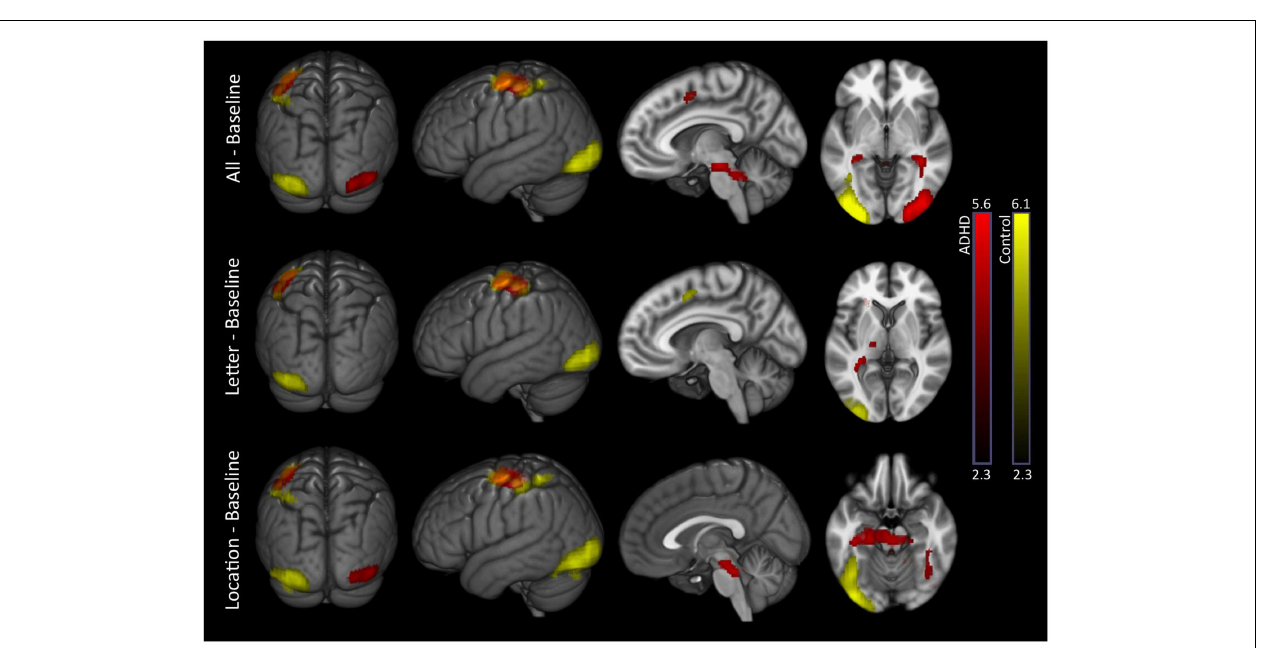
inferior medial), and post-central gyrus boarding the supramarginal gyrus. ADHD subjects showed additional unique subcortical activations that included thalamus, brainstem, cerebellum, and hippocampus. Images are thresholded using a voxelwise threshold of z = 2.3 and a cluster size probability of p < 0.05.